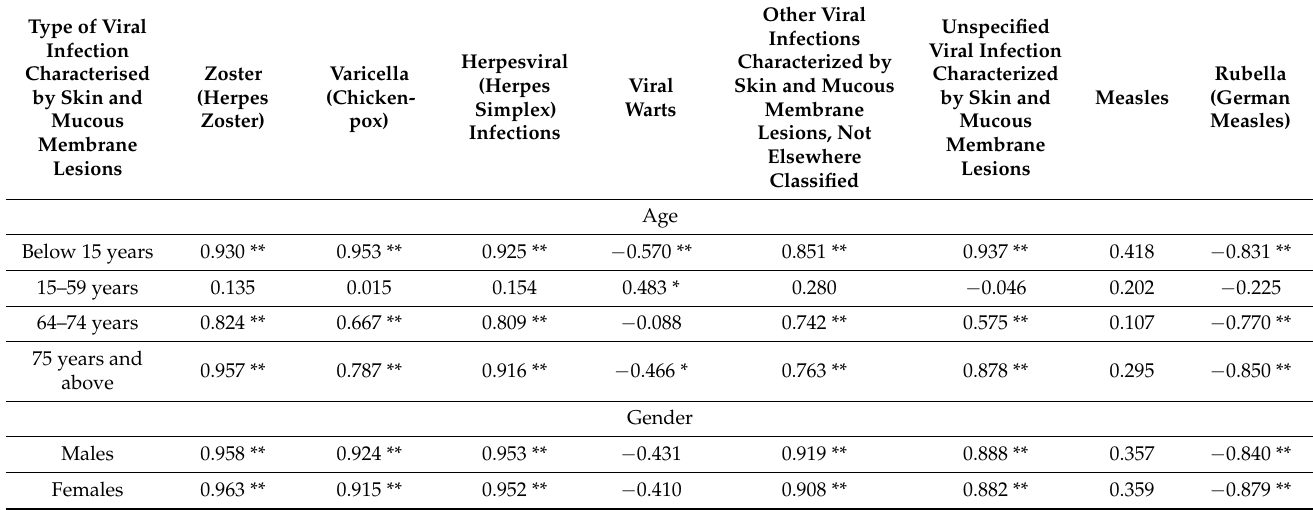
Table 3. Correlation between viral infection characterised by skin and mucous membrane lesions admissions and age and gender between 2004 and